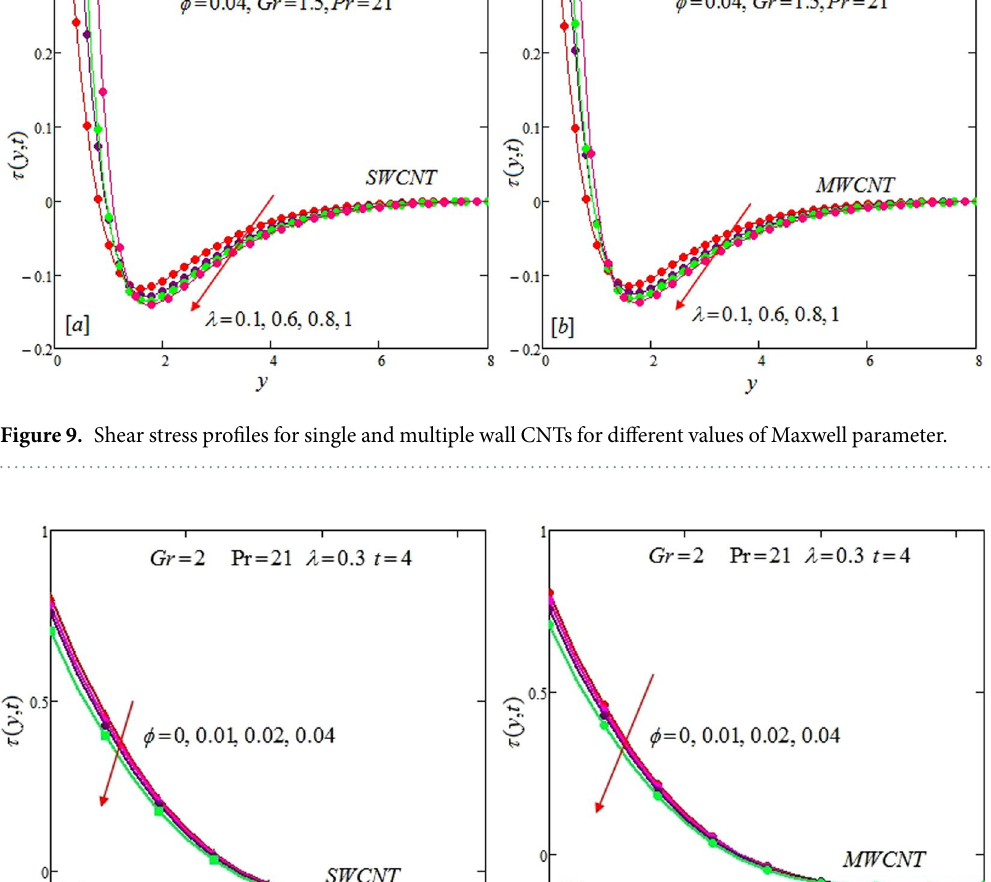
Table 4. It is found that the present results of Nu for regular fluid ( φ = 0) are in excellent agreement with published results of Farhad et al . 47 . This theoretical comparison confirms the accuracy of the present work.